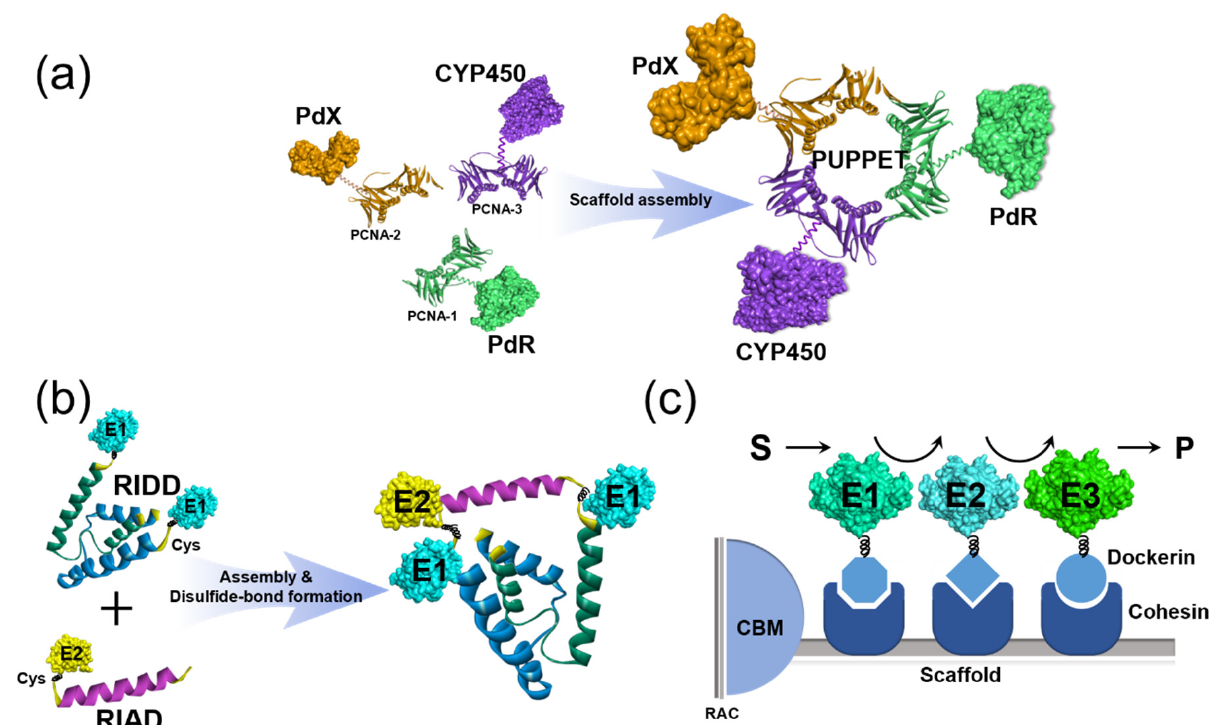
Figure 2. Assembly of enzymes with high-affinity protein and peptide-interaction domains. ( a ) Proliferating cellular nuclear antigen (PCNA)-based heterotrimeric complex formation of a cytochrome P450s (CYP450) with its redox partners (PdX, and PdR) to a ring-shaped electron transfer scaffold (PUPPET) [97]. ( b ) Co-localization of enzyme assemblies driven by the interaction of RIAD and RIDD peptide pairs that result in disulfide bond formation [39]. ( c ) Scaffolding of enzymes on a designer cellulosome via specific interactions of orthogonal dockerin and cohesin pairs. A cellulose binding domain (CBM) can be fused to the cellulosome protein scaffold allows for attachment to regenerated amorphous cellulose (RAC).